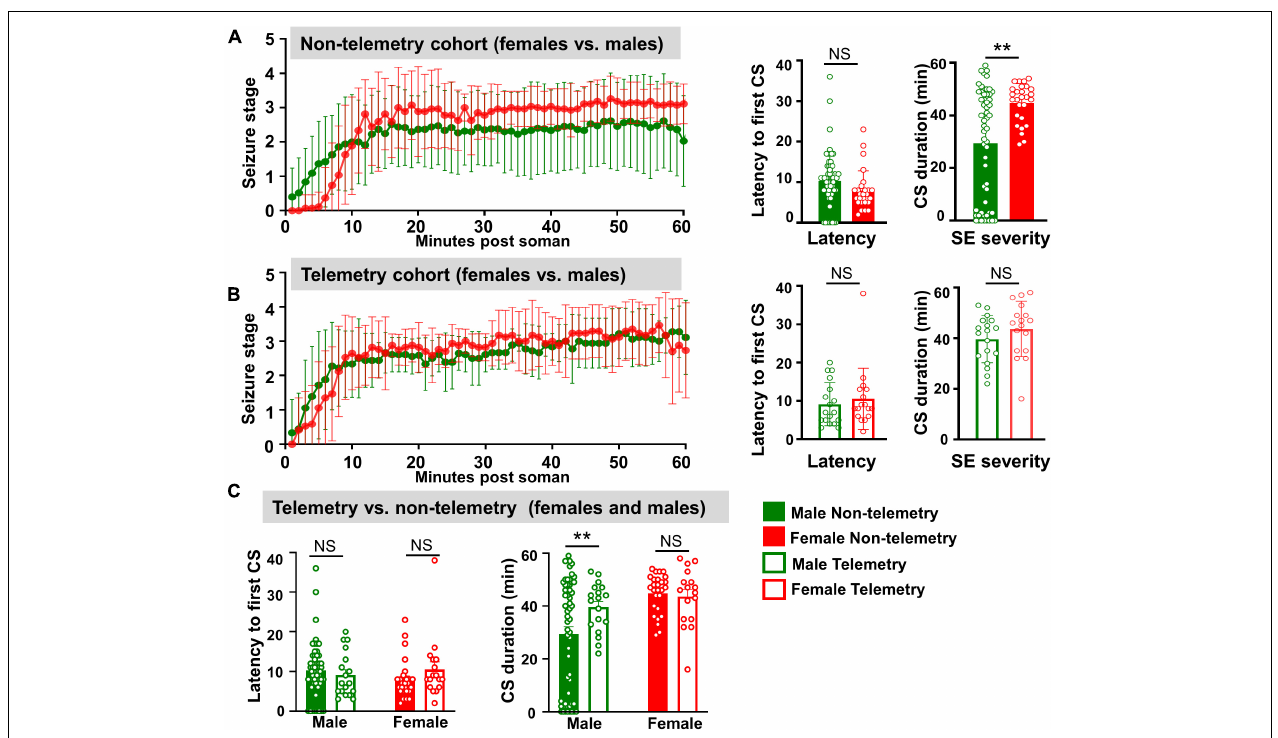
FIGURE 2 | Behavioral SE severity and latency to the onset of first CS comparison between sexes and telemetry versus non-telemetry animals. (A) Seizure stage overtime, latency to first CS and CS duration in non-telemetry males and females. (B) Seizure stage overtime, latency to first CS and CS duration in telemetry males and females. (C) Latency to first CS and CS duration comparison between non-telemetry and telemetry animals. Mixed measures ANOVA, or Mann–Whitney ( n = 18–57). ** p <